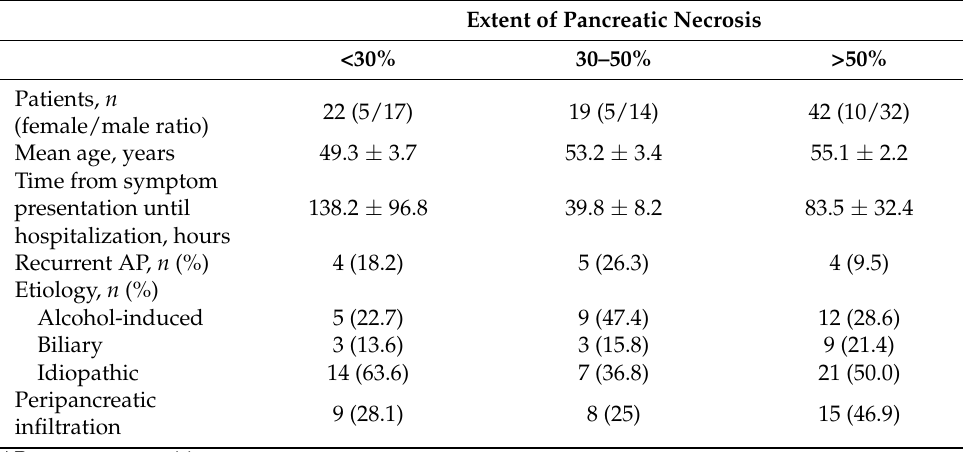
Table 1. Clinical data by the extent of pancreatic necrosis.